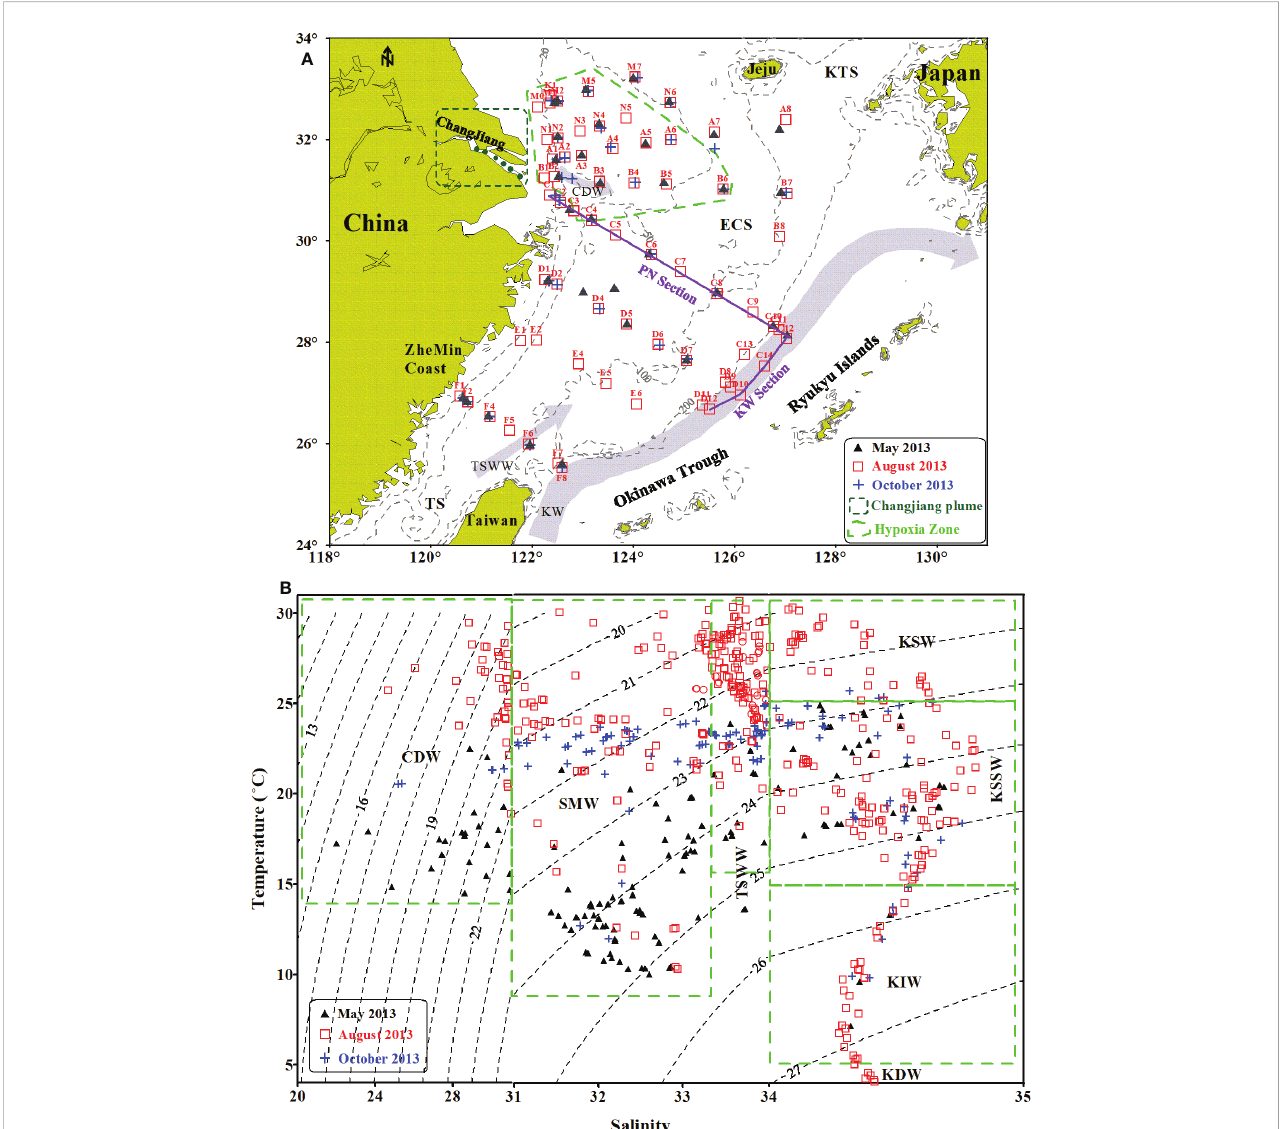
FIGURE 1 (A) Sampling stations of three cruises across the East China Sea in 2013 ( ▲ : May, □ : August, +: October), with illustrations of circulation regimes, including the Changjiang Diluted Water (CDW), Kuroshio Water (KW) and Taiwan Strait Warm Water (TSWW). Sampling stations in the Changjiang plume are indicated with a rectangle. The PN Section (from the Changjiang Estuary to the Ryukyu Islands) and KW Section (along the KW in the ECS edge) are highlighted by purple solid lines. The green dashed area represents the Hypoxia Zone that occurred in near-bottom waters outside the Changjiang Estuary (DO < 100 m M) in summer 2013. (B) A plot of salinity-temperature data for the ECS, which includes the Changjiang Diluted Water (CDW), Shelf Mixed Water (SMW), Taiwan Strait Warm Water (TSWW), Kuroshio Surface Water (KSW), Kuroshio Subsurface Water (KSSW), Kuroshio Intermediate Water (KIW), and Kuroshio Deep Water (KDW) (Su, 1998; Qi et al., 2014). (ECS, East China Sea; TS, Taiwan Strait; KTS, Korea/Tsushima